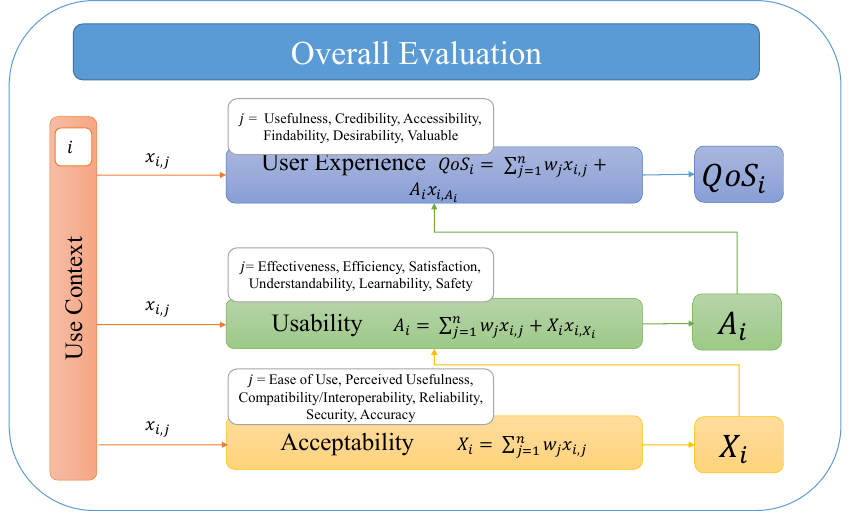
Figure 6. Overall Evaluation. The figure puts in evidence how the different individual levels of the proposed architectural model can be chained to provide an overall evaluation.The figure also takes into account the role of the use context in the definition of the attributes’